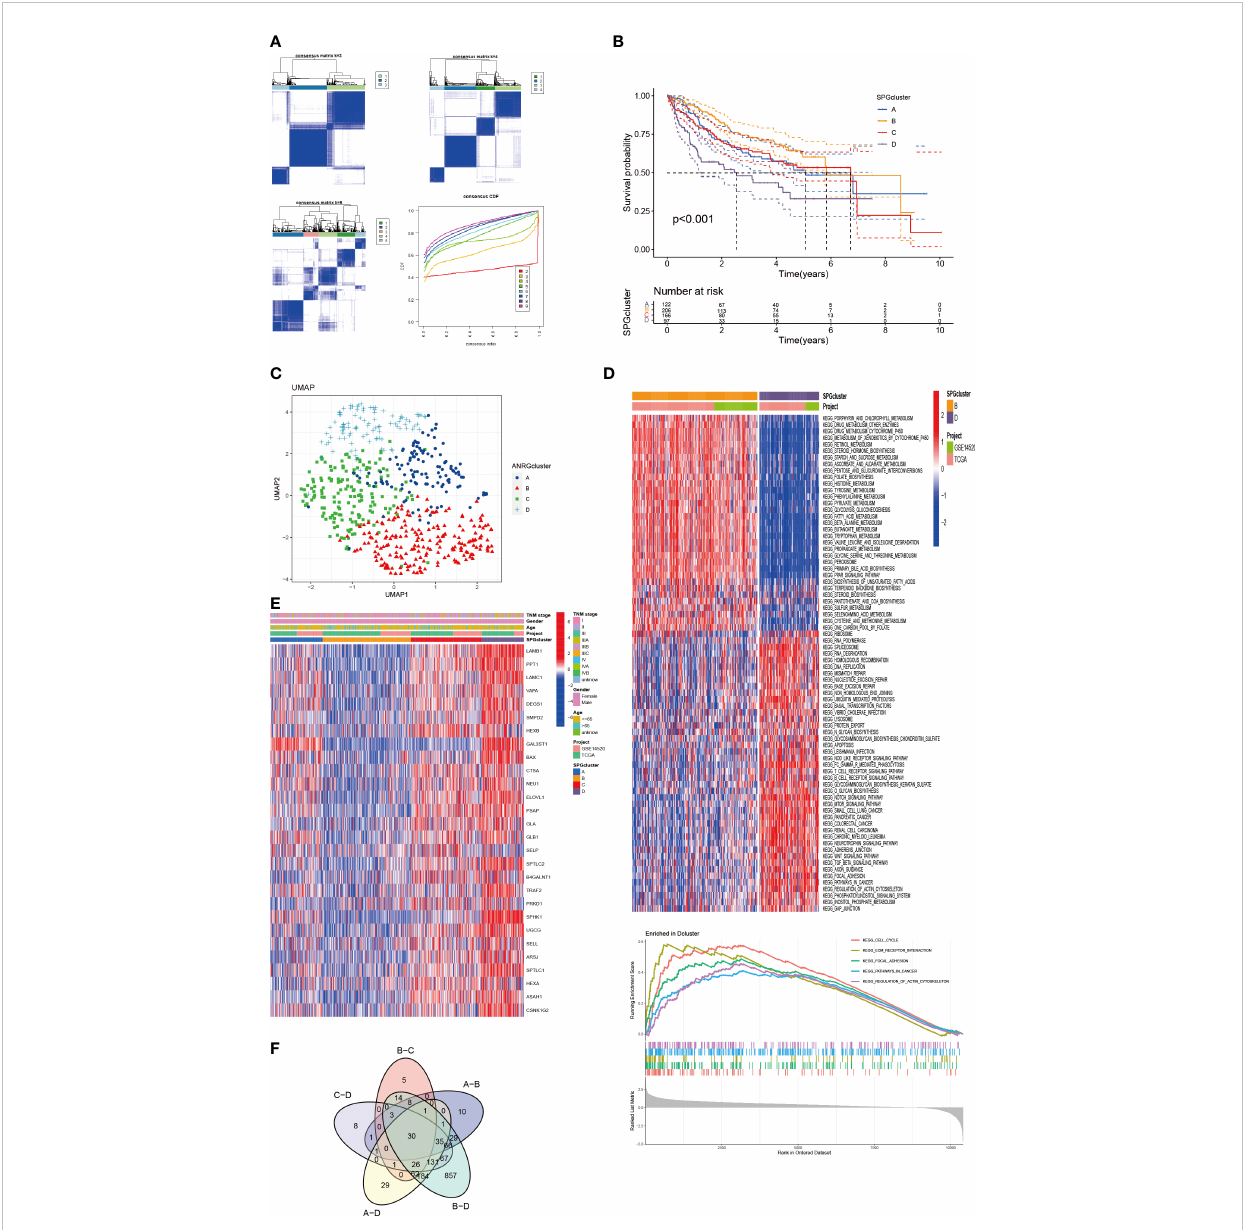
FIGURE 2 HCC Subgroups classi fi ed by SPGs. (A) Consensus matrix for k=4 was accepted using consensus clustering. (B) Survival probability of 4 subtypes ( P < 0.01). (C) UMAP distinguished 4 subtypes based on SPGs expression level. (D) Clusters D and B were analyzed differently using GSVA in terms of KEGG pathway enrichment. (E) Clinical and pathological features of four subtypes of SPGs expression. (F) Differential SPGs-based clusters intersected on Venn